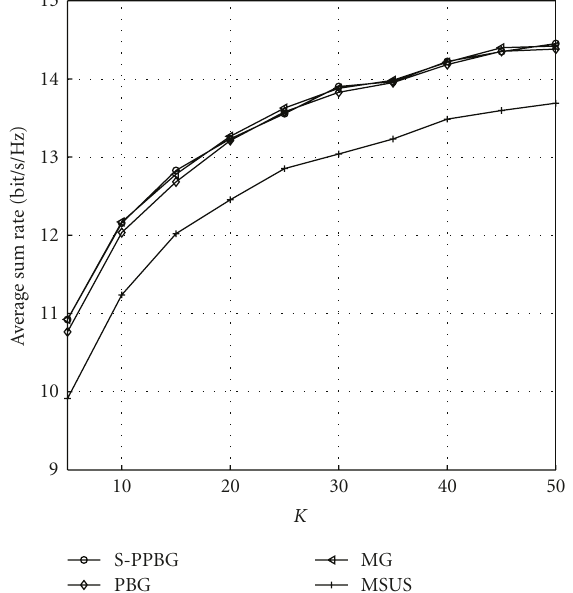
Figure 2: Average sum rate as versus the total number of users K . Scheduling objective is the maximization of the sum rate.